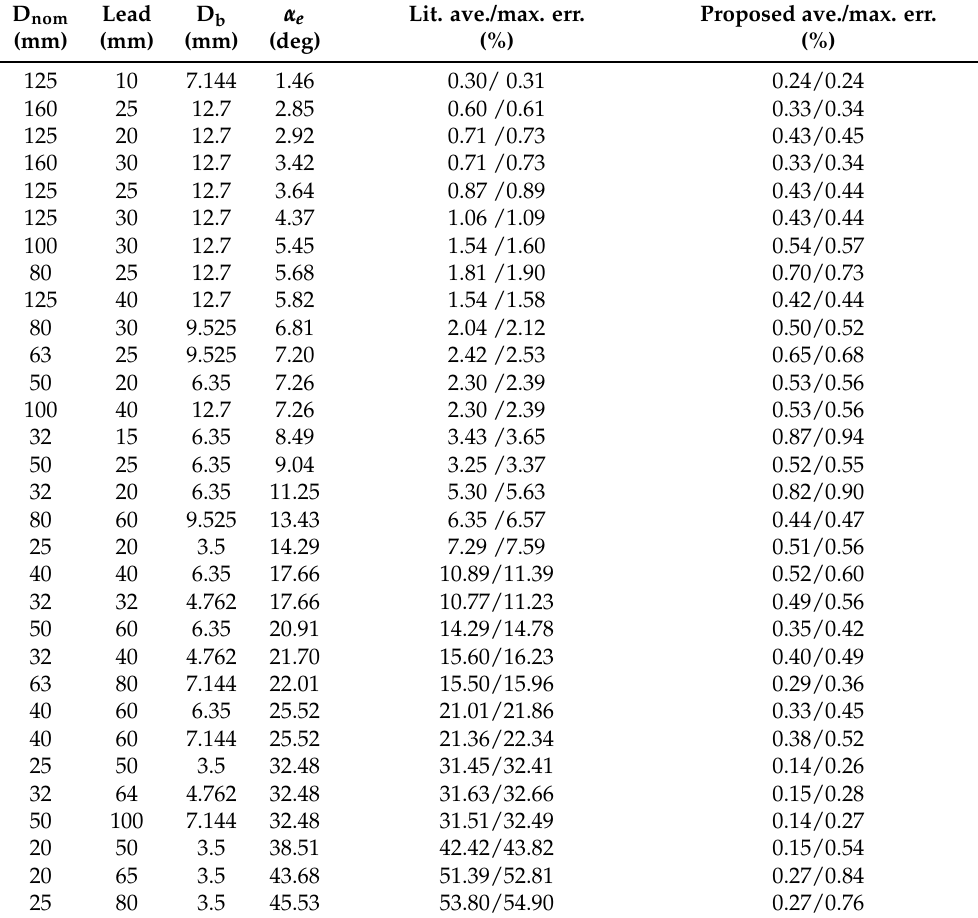
Table A1. Relative errors on the screw shaft curvature committed by using the literature and proposed formulations for different off-the-shelf ball screws sizes, defined by the nominal diameter D nom , the lead and the spheres’ diameter D b . D nom Lead D b α e α e α e Lit. ave./max. err. Proposed ave./max.